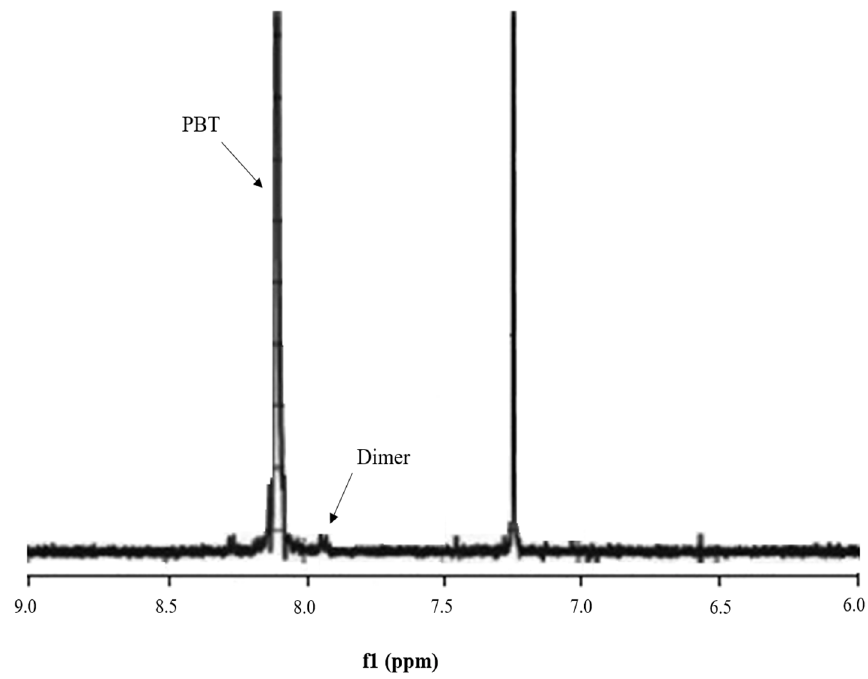
Figure 3. 1 H-NMR spectra for PBT collected after the compressed CO 2 antisolvent treatment.